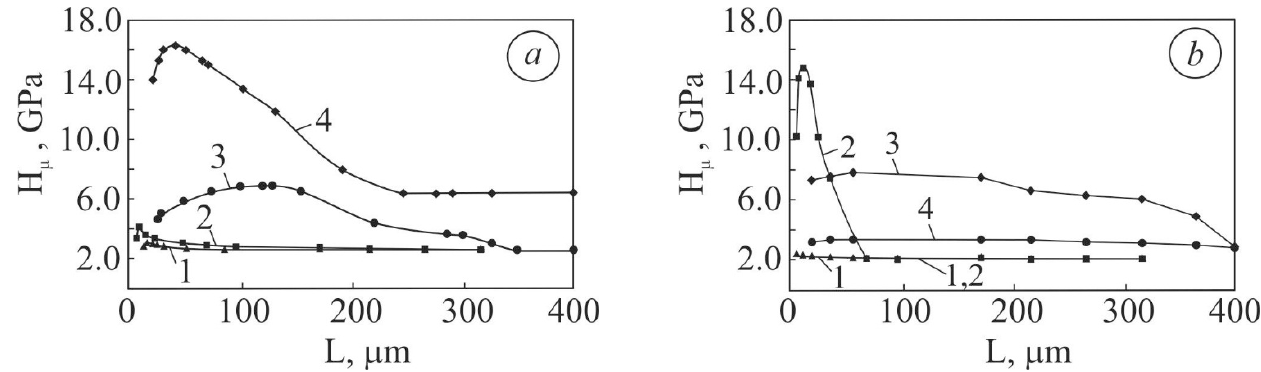
Figure 3. The microhardness variation in the surface layers on steel ( a ) AISI 420 and ( b ) AISI 304: 1—initial state; 2—after laser alloying with a plaster of 85Nb + 15% graphite, 3—85 Nb + 15% liquid glass, 4—15Fe + 30Ni + 20B + 10Si + 25% liquid glass.